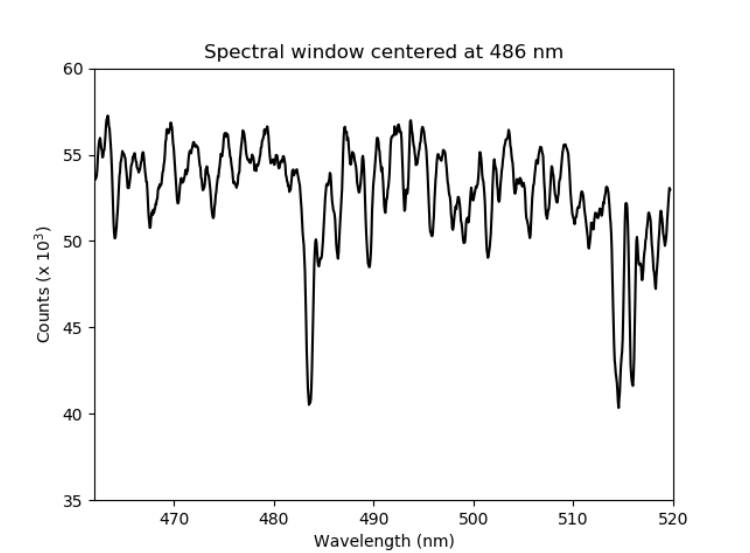
Figure 2. Zenith spectrum acquired at 11:27 UTC of 27 November 2018 by GASCOD/NG4 in the spectral window centered at 486 nm in arbitrary units. It was not radiometrically calibrated, since DOAS analysis does not require it.